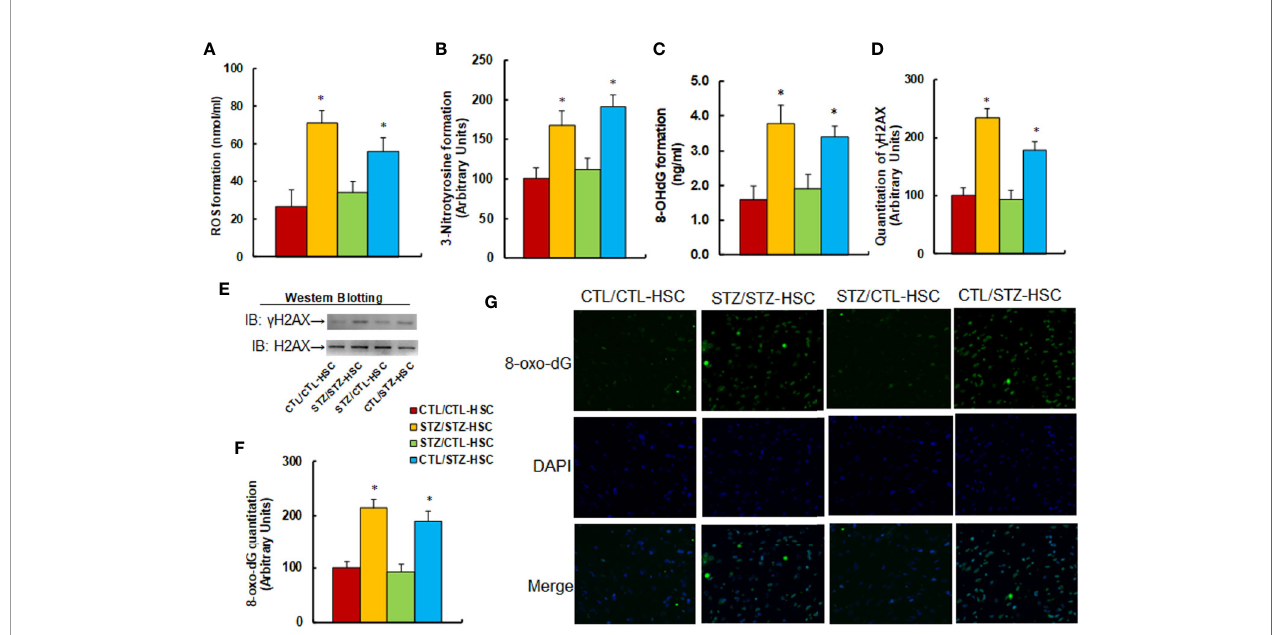
FIGURE 3 | Transplantation of bone marrow HSC reverses maternal diabetes-induced oxidative stress in PBMC in autistic offspring. The 6-week-old male offspring from either the control (CTL) or maternal diabetes (STZ) groups received transplantation of bone marrow HSC from either the control (CTL-HSC) or maternal diabetes (STZ-HSC) group, and the mice were used for further biomedical analysis 5 weeks after transplantation. (A) ROS formation in PBMC, n = 5. (B) Quantitation of 3-nitrotyrosine formation, n = 5. (C) 8-OHdG formation, n = 5. (D) Quantitation of g H2AX formation. (E) Representative g H2AX western blotting band for (D) , n = 5. (F) Quantitation of 8-oxo-dG formation, n = 5. (G) Representative pictures of 8-oxo-dG staining for oxidative stress (green) and DAPI staining for nuclei (blue) in PBMC, n = 4. * P < 0.05, vs. CTL/CTL-HSC group. Data were expressed as mean ± SEM.